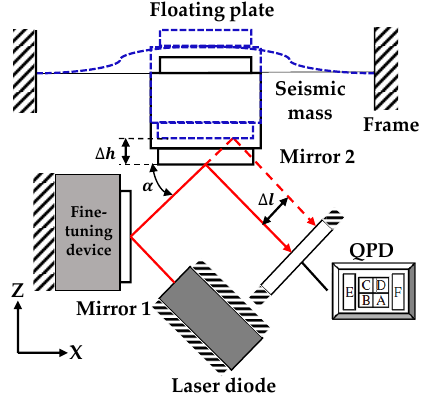
Figure 2. The schematic of an optical accelerometer. QPD: four-quadrant photodetector.